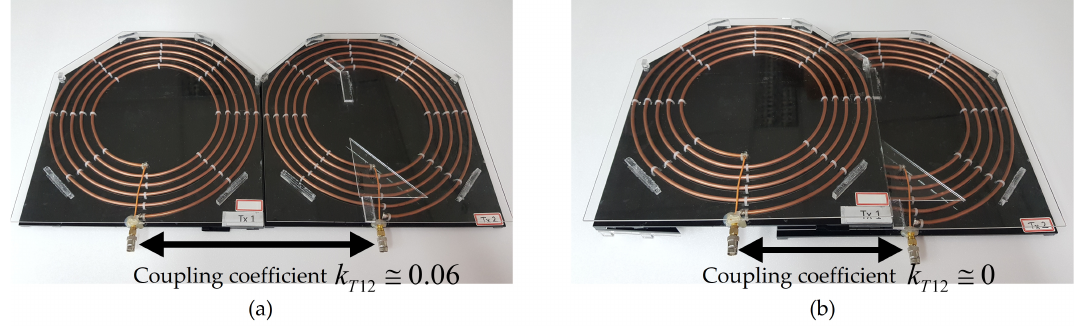
Figure 8. Adjustment of k T 12 by overlapping method: ( a ) k T 12 = 0.06 and ( b ) k T 12 = 0.